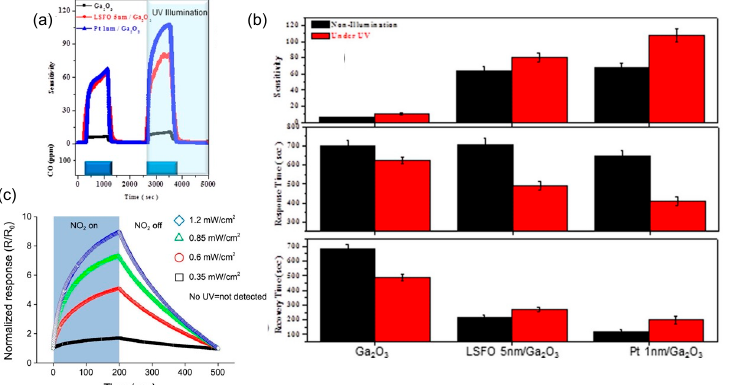
Figure 19. CO gas ‐ sensing performance comparison of pristine, LSFO ‐ decorated, and Pt ‐ decorated β‐ Ga 2 O 3 nanorod arrays: ( a ) normalized sensitivity time characteristics and ( b ) sensitivity, recovery time, and recovery time under dark or UV illumination tested at 500 °C [155]. Copyright 2017 American Institute of Physics. ( c ) Room temperature gas responses of Pt ‐ functionalized Ga 2 O 3 nanorod gas sensors to 5 ppm NO 2 under UV light illumination with varied intensities [128]. Copyright 2013 Korean Chemical Society.